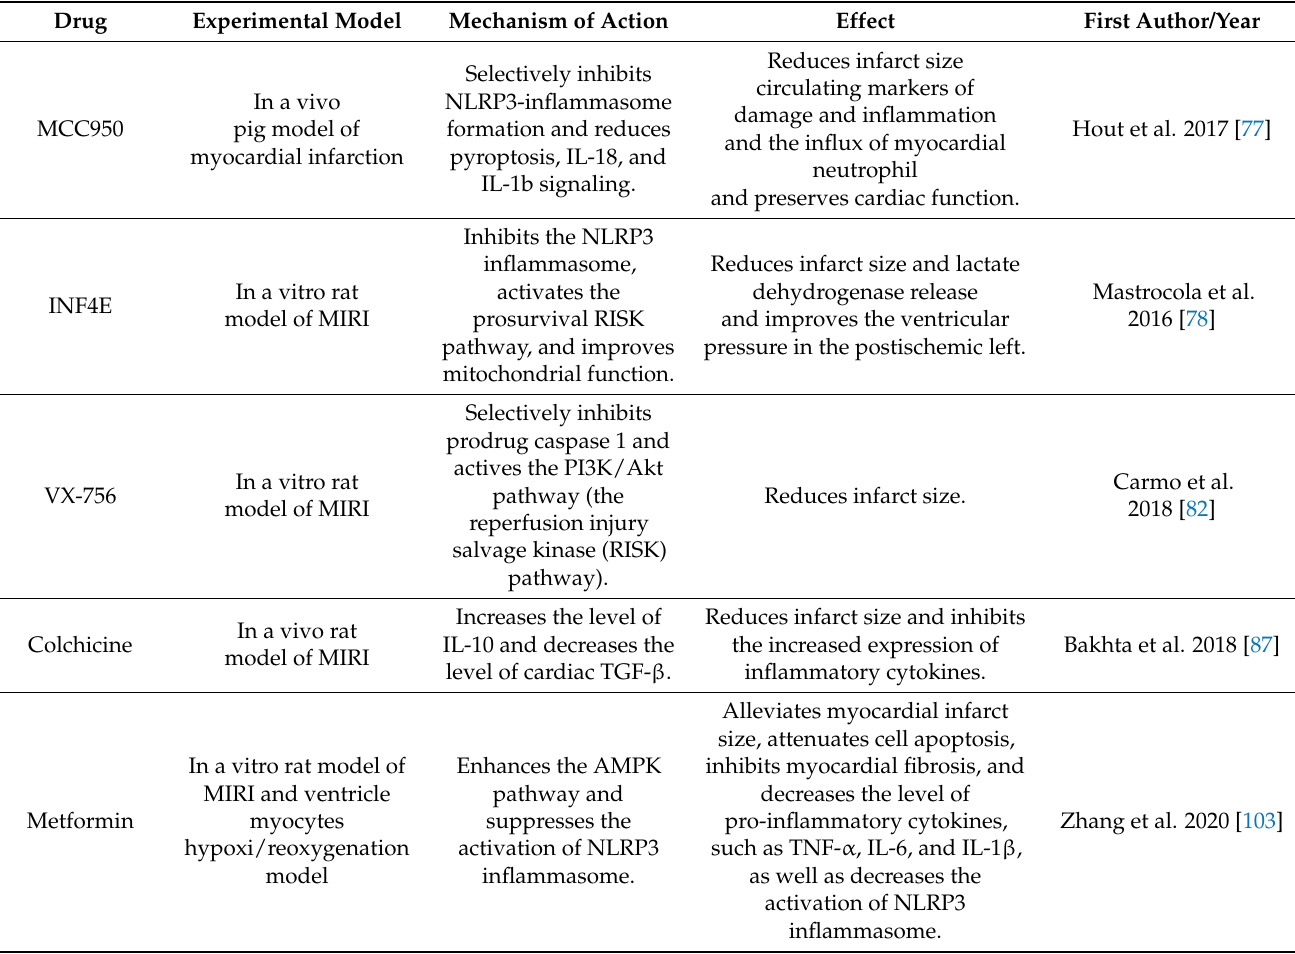
Table 2. Drugs alleviate myocardial ischemia-reperfusion injury by affecting pyroptosis. Drug Experimental